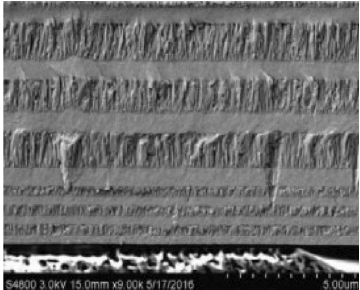
Figure 12 Cross section morphology of the photonic crystal sample cross section